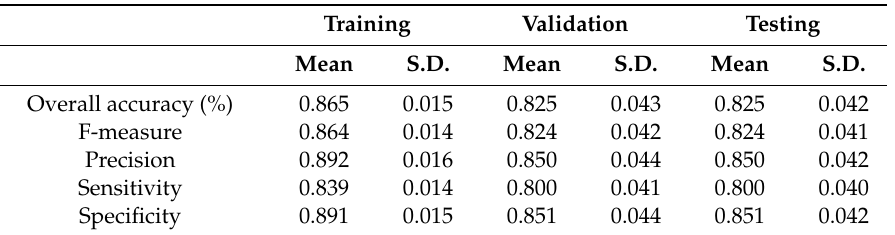
Table 4. Classification results.